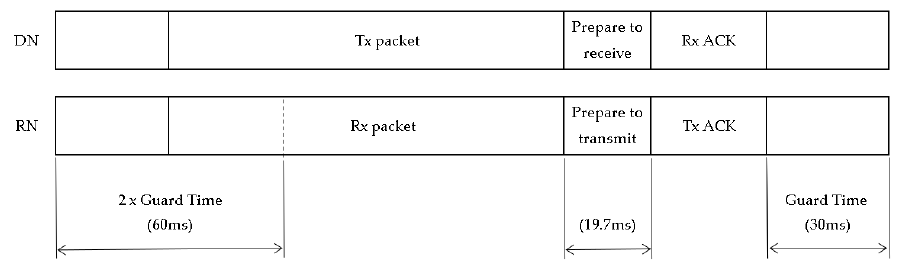
Figure 4. Time-slot structure.